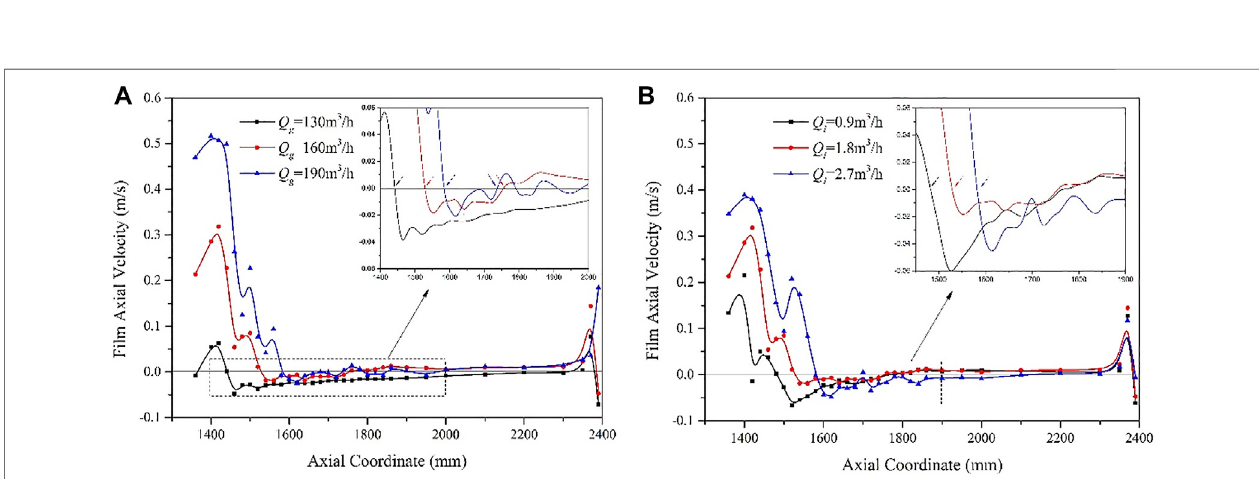
FIGURE 10 | Axial distribution of USLF azimuth-time-averaged axial fi lm velocity under different (A) gas fl owrates and (B) liquid fl owrates.